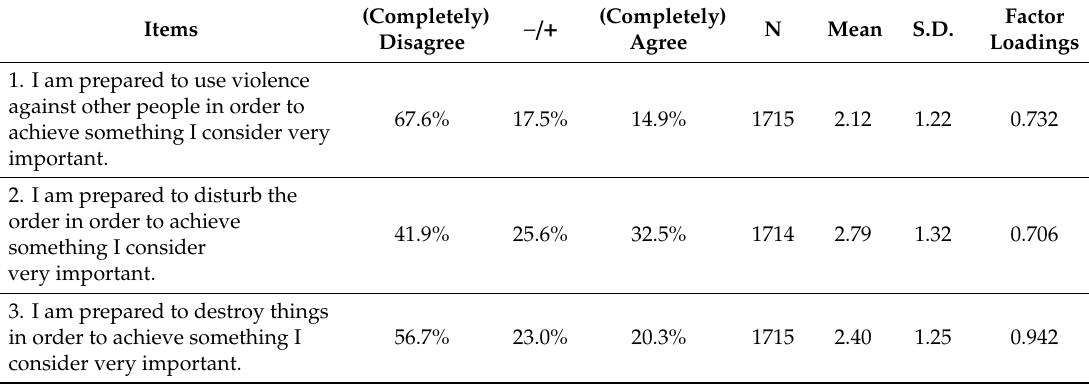
Table 2. Item wordings and descriptors of attitude items “willingness to use violence”.